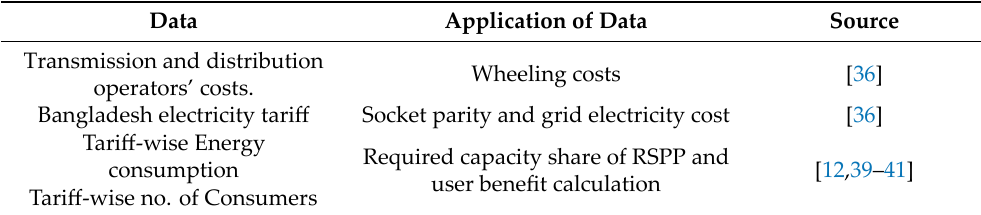
Table 7. Collected data, applications of data and sources.